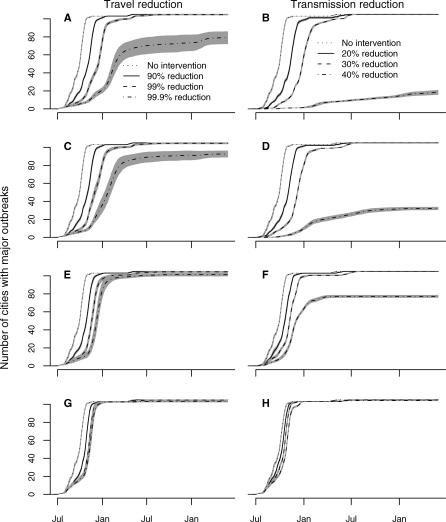
Impact of Interventions and Implementation Delays on Rate and Extent of SpreadEffect of reducing travel (A, C, E, and G) and transmission (B, D, F, and H) on the timing of major outbreaks (≥ 1 case per 10,000 per day) in 105 cities using contemporary transport and demographic data and baseline parameters. Transmission reductions are imposed in each city after one case in the given city (A and B); 100 cases (C and D); 1,000 cases (E and F); and 10,000 cases (G and H). Interventions in the originating city (Hong Kong) occur after 1,000 cases (A–F) or 10,000 cases (G and H). Lines and shaded regions show means of 100 simulation runs and ± standard deviation, respectively. In all cases, R
0,max = 3. and the proportion of the population initially susceptible is 0.6.